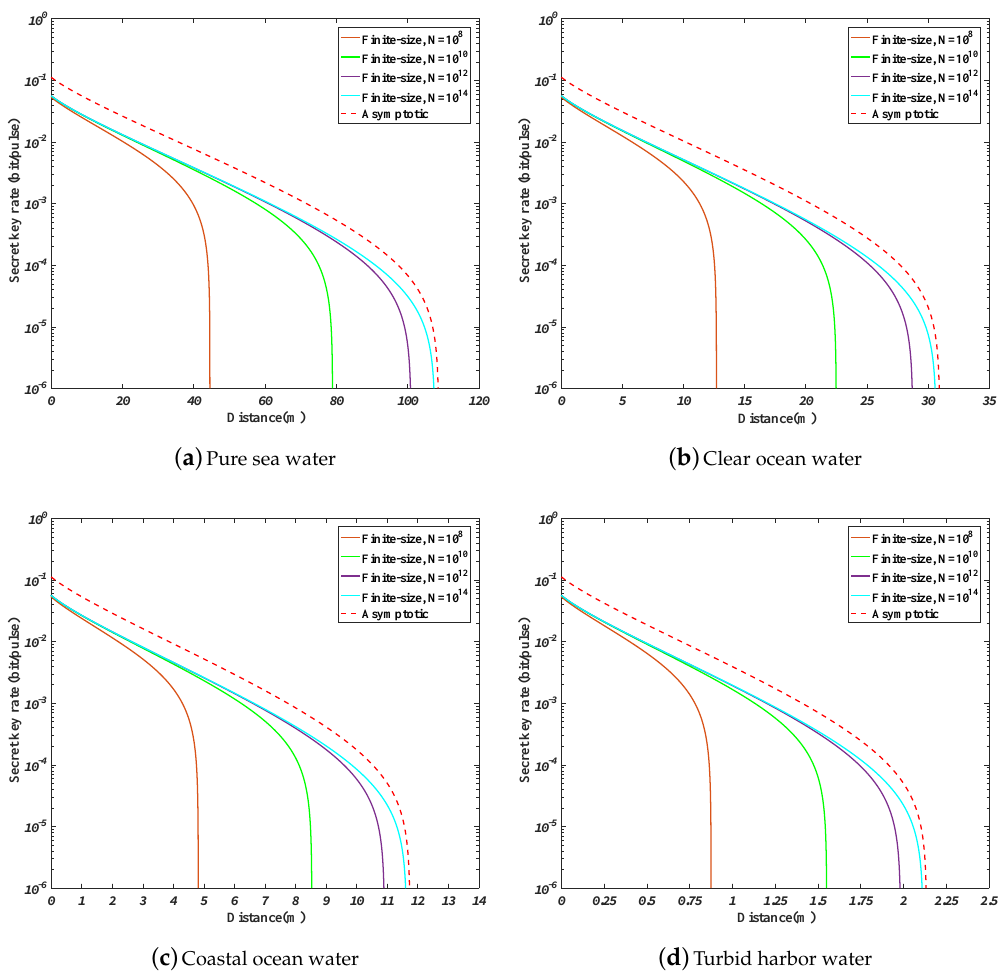
Figure 12. (Color online.) The finite-size and the asymptotic secret key rate of the eight-state underwater CV-QKD protocol. From left to right in every sub-figure, curves of different colors correspond, respectively, to block lengths of 10 8 , 10 10 , 10 12 , and 10 14 , and the asymptotic